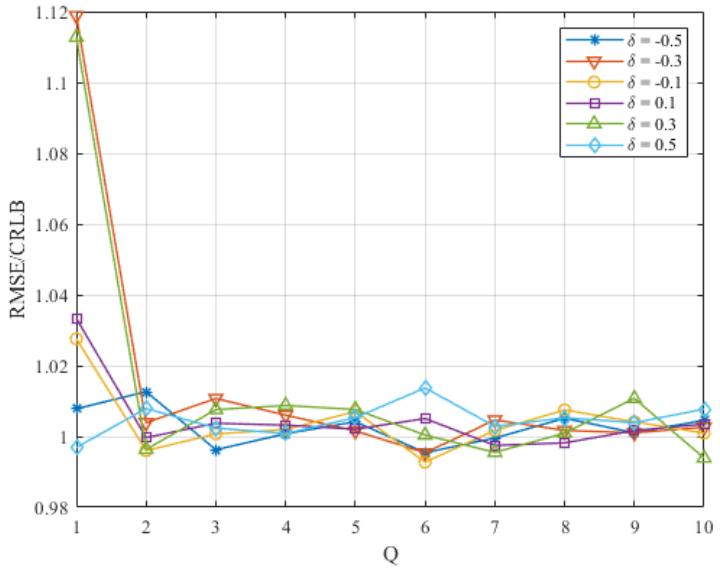
Figure 5. The RMSE/CRLB of the proposed estimator versus Q at different values of δ when SNR = 0 dB and N =